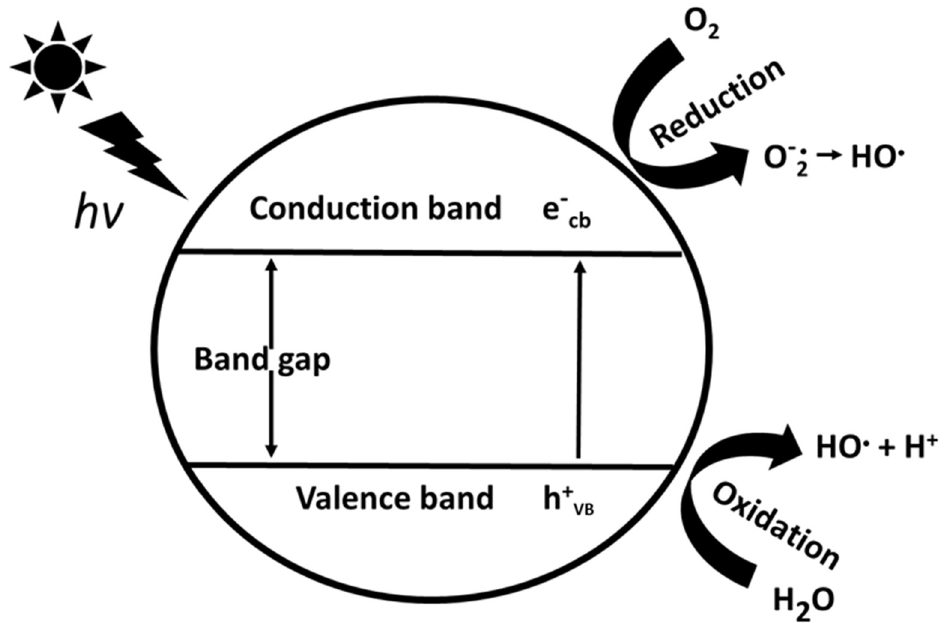
Figure 4. Schematic illustration of a model photocatalytic system showing the contribution of hole-electron couples to the formation of radicals.